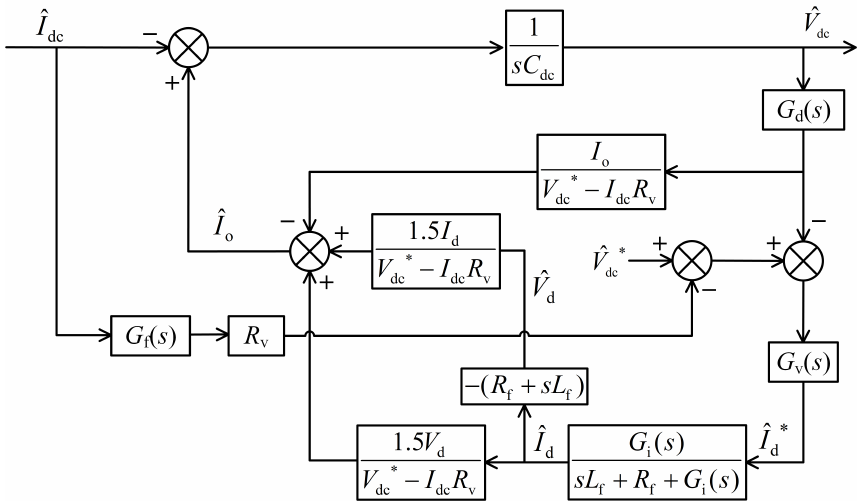
Figure 5. The proposed transfer function block scheme of voltage droop controlled grid-forming VSC.